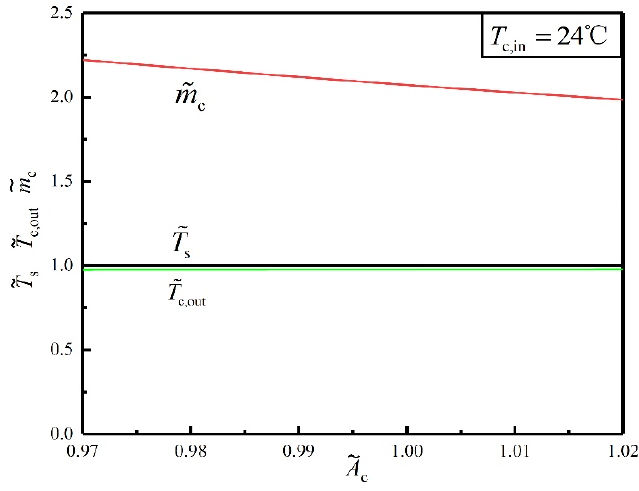
 A on the   A on the  c c